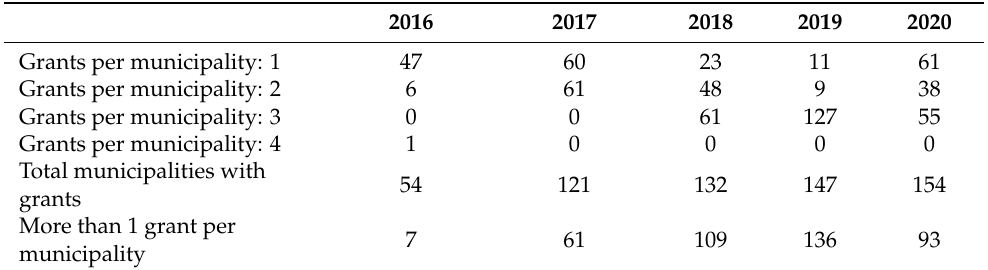
Table 3. Number of municipalities with consideration of the number of grants in a given year.